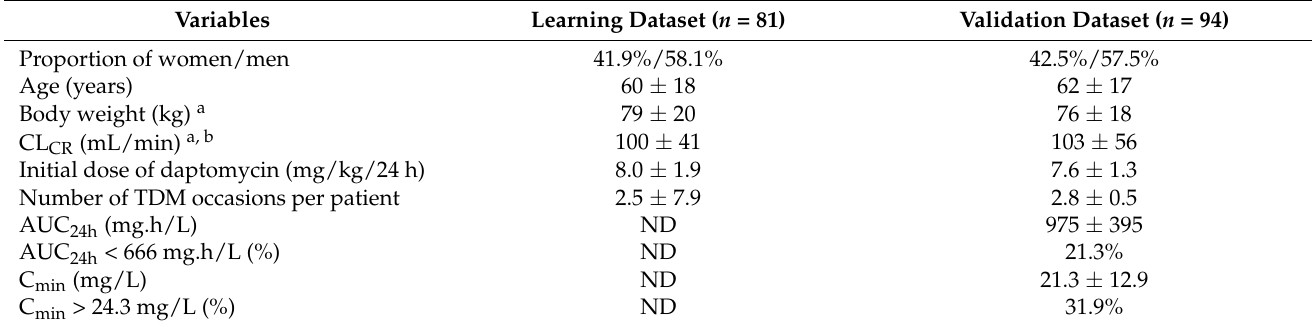
Table 1. Population characteristics.